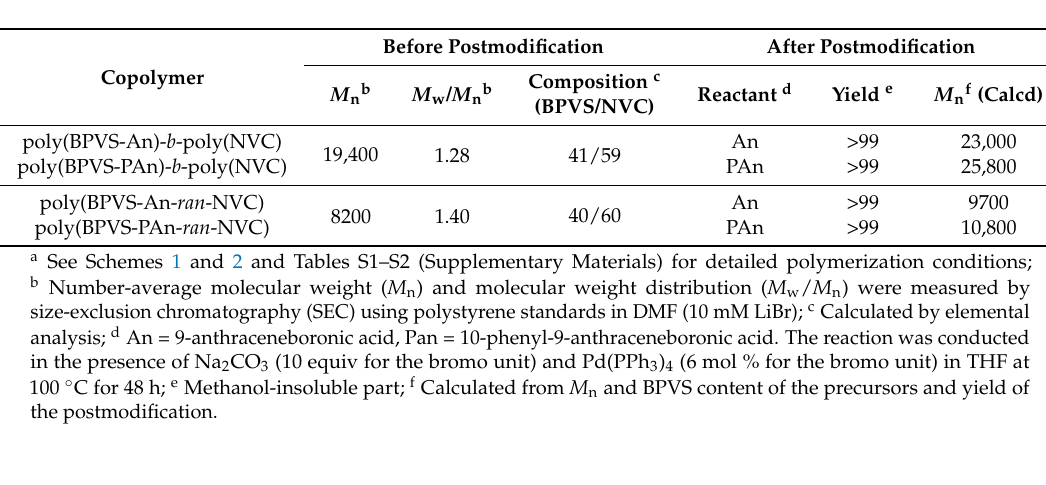
Table 1. Characterization data of block and random copolymers prepared by RAFT polymerization, followed by postmodification a .